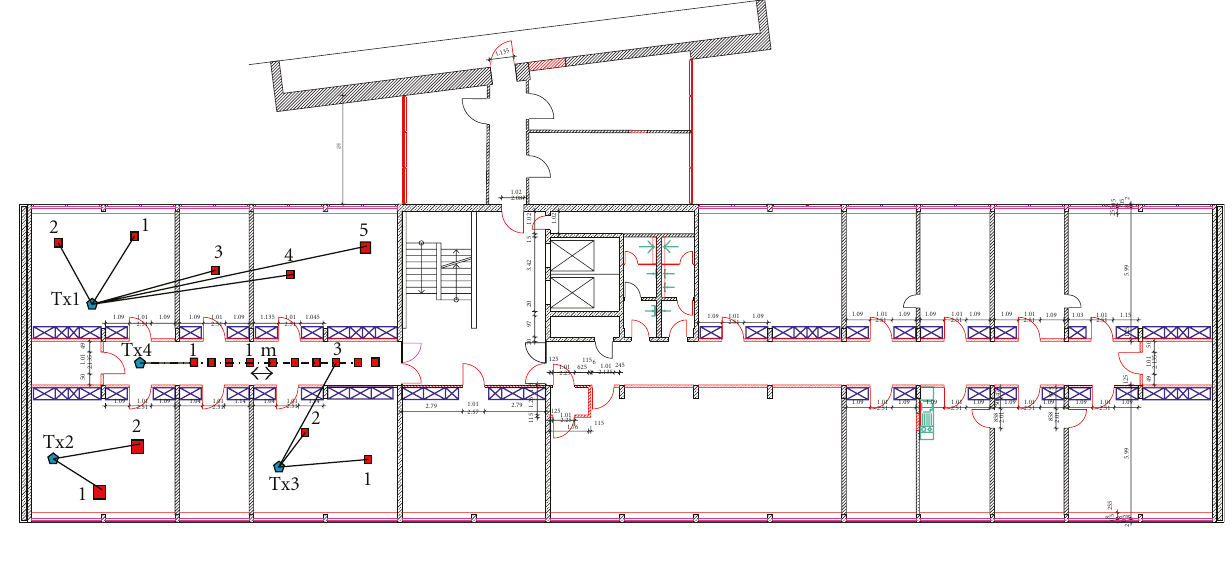
Figure 2: Indoor transmitter and receiver locations.